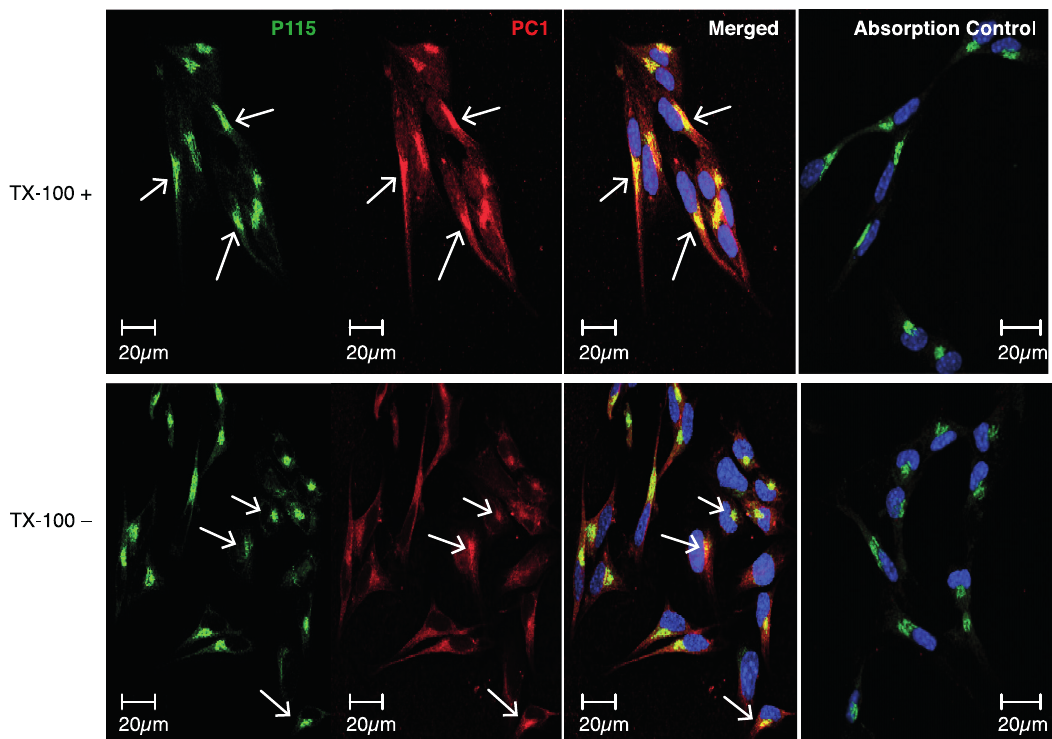
Figure 5. Immunocytochemical analysis of PC1 C-terminus in AtT20 cells. AtT20 cells were chemically fixed with 2% PFA/PBS and then treated with and without the detergent, Triton X-100. PC1 was stained with C-terminal specific immunopurifed IgGs by indirect immunofluorescence. In the Triton X-100 treated cells, the staining pattern of the C-terminus of PC1 was similar to that of the N-terminus of PC1 described in Figure 3, in that Golgi staining (arrows) was observed (top panel). In the Triton X-100 untreated cells, however, a reduced but similar staining pattern was observed to that of the Triton X-100 treated cells (lower panel). This demonstrates that some of the C-terminus of PC1 was localized in the cytosol. B ar 20 m m.